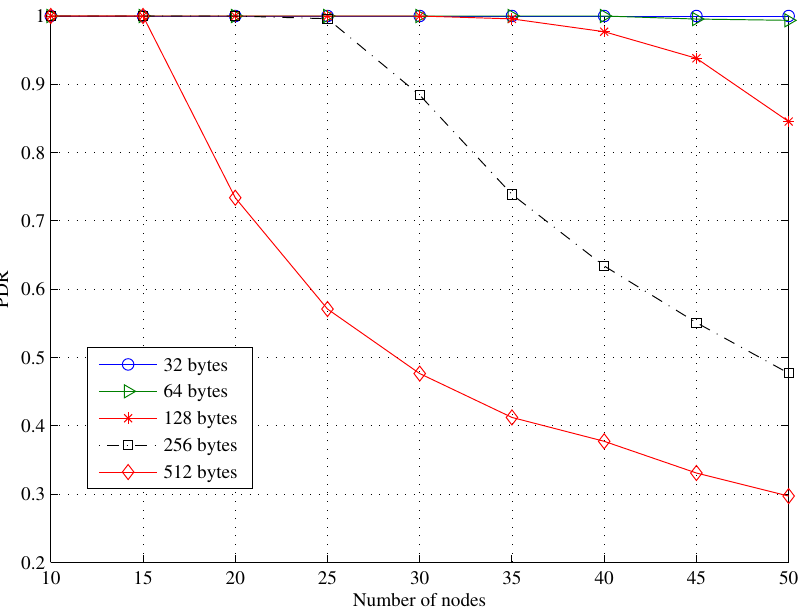
Figure 10. Packet delivery ratio (PDR) vs. No. of